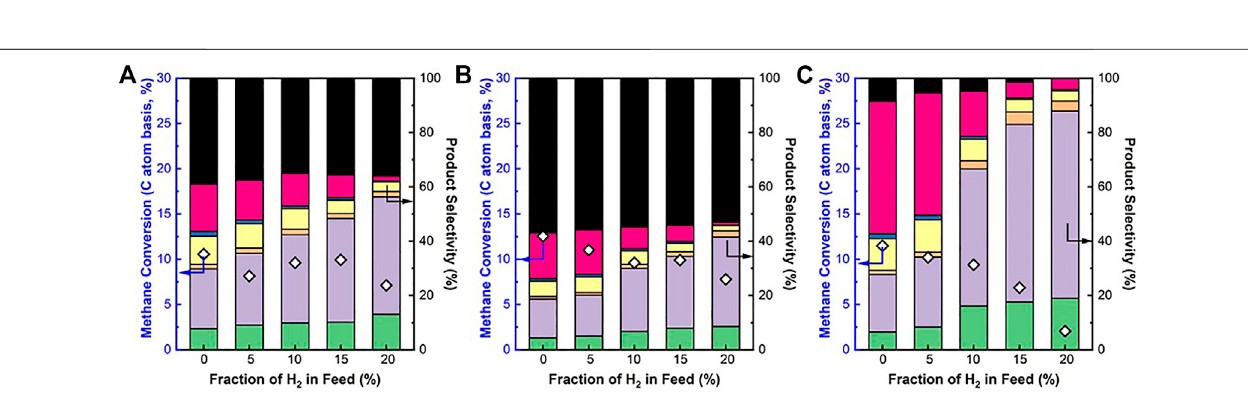
FIGURE6| CH 4 conversionandproductselectivityinDNMCreactionoverFe/SiO 2 catalystandSCZOperovskiteoxidemixturewithdifferentsamplearrangement: (A) SCZOpacked ontopofFe/SiO 2 , (B) SCZOpacked belowFe/SiO 2 ,and (C) SCZOandFe/SiO 2 wellmixed[mass ratioofSCZOtoFe/SiO 2 (cid:1) 1:2in (A) and (B) and5: 95 in (C) , 1273 K temperature, 101.325 kPa pressure, 2,133 mlg − 1 h − 1 (A) and (B) and 3,200 mlg − 1 h − 1 (C) space velocities, molar ratio of N 2 /CH 4 (cid:1) 1/9, N 2 used as internal standard, ToS of 1 h] (symbol indicators: coke, naphthalene, toluene, benzene, ethane, ethylene, and acetylene).